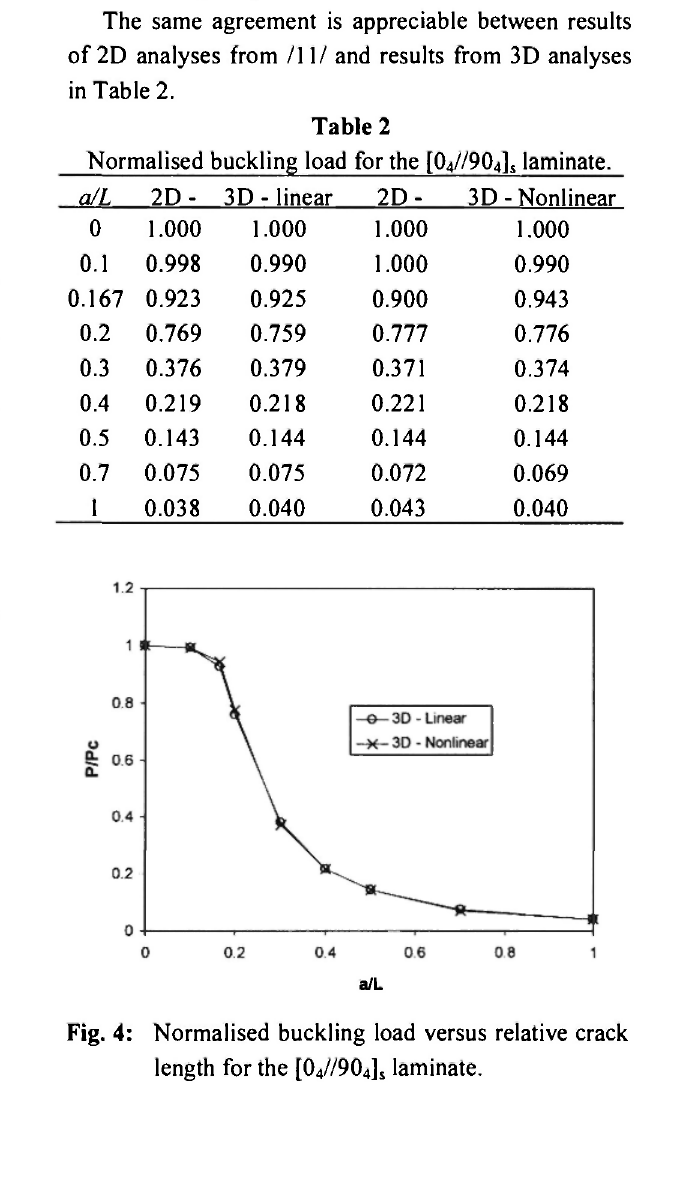
Fig. 3: Influence of the number of nodes on the solution.